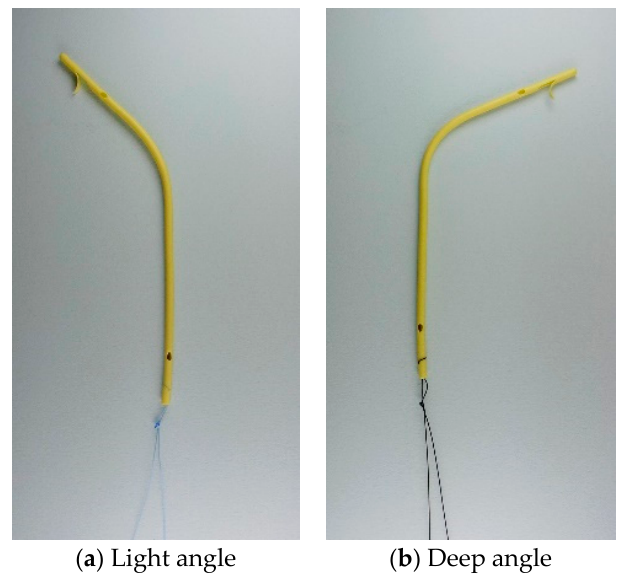
Figure 1. Commercially available inside stents (ThroughPass IS, Gadelius Medical K.K., Tokyo, Japan). There are two types of central bends, light angle ( a ) and deep angle ( b ). The angles of central bends were 34 degrees in the light angle and 75 degrees in the deep angle. The retrieval thread attached to the distal end was made of Nylon and 10 cm long.